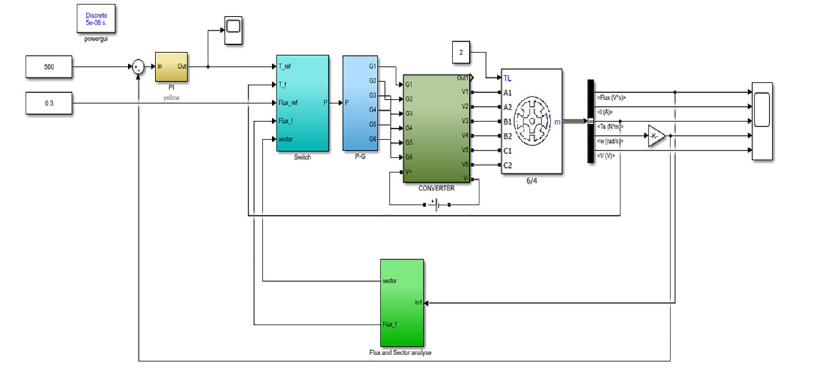
Fig 7. Simulation model of 6/4 pole SRM system simulation